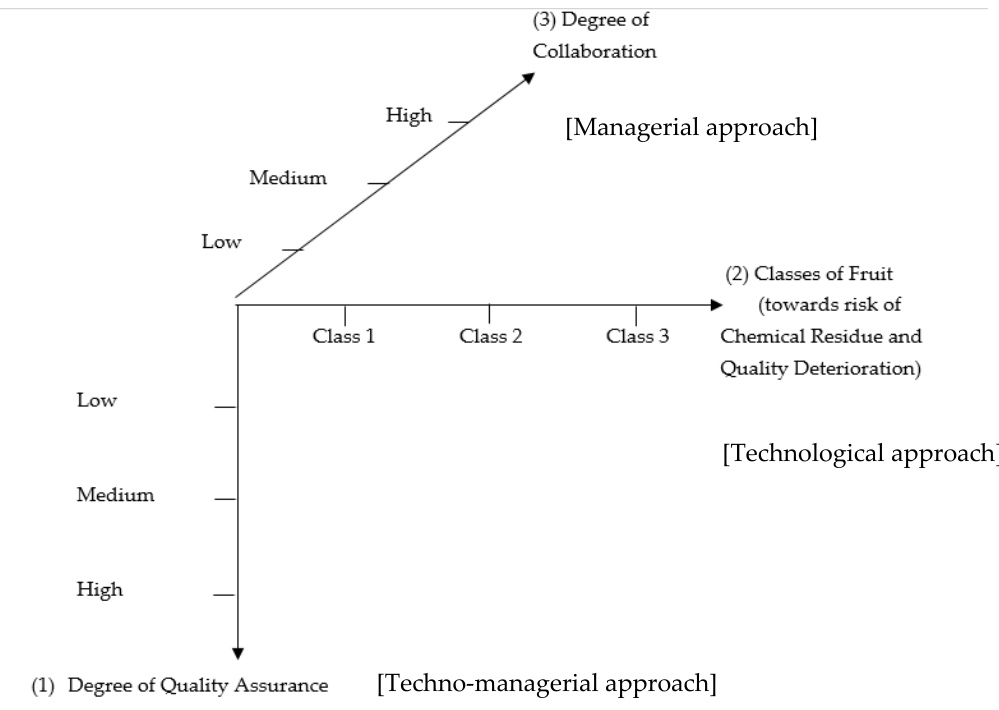
Figure 1. Three axes model as a research model.